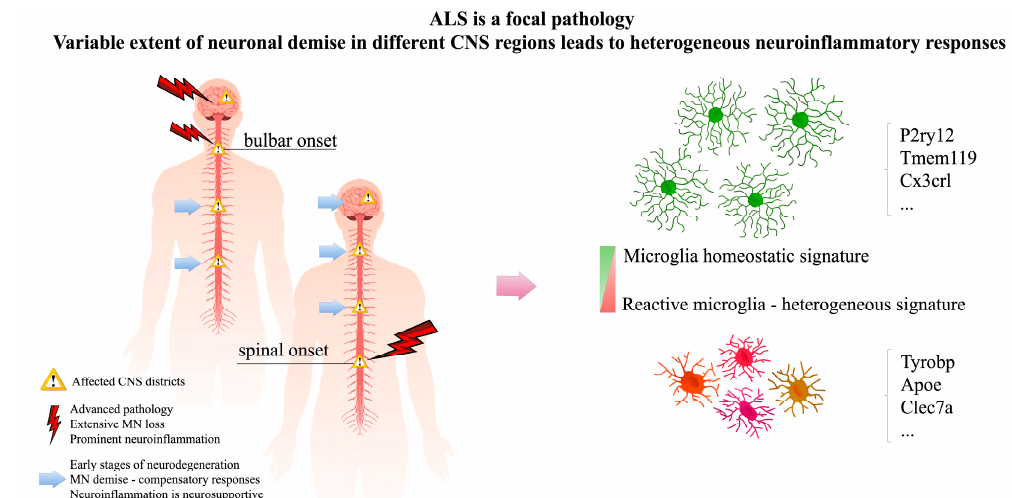
Figure 1. Amyotrophic Lateral Sclerosis (ALS) is a complex pathology. There is variability in the extent of neuronal demise in different central nervous system (CNS) districts affected by the disease. This leads to heterogeneity of neuroinflammatory (microglia) responses, characterized by variable engagement in the attempt to cope with neuronal demise.